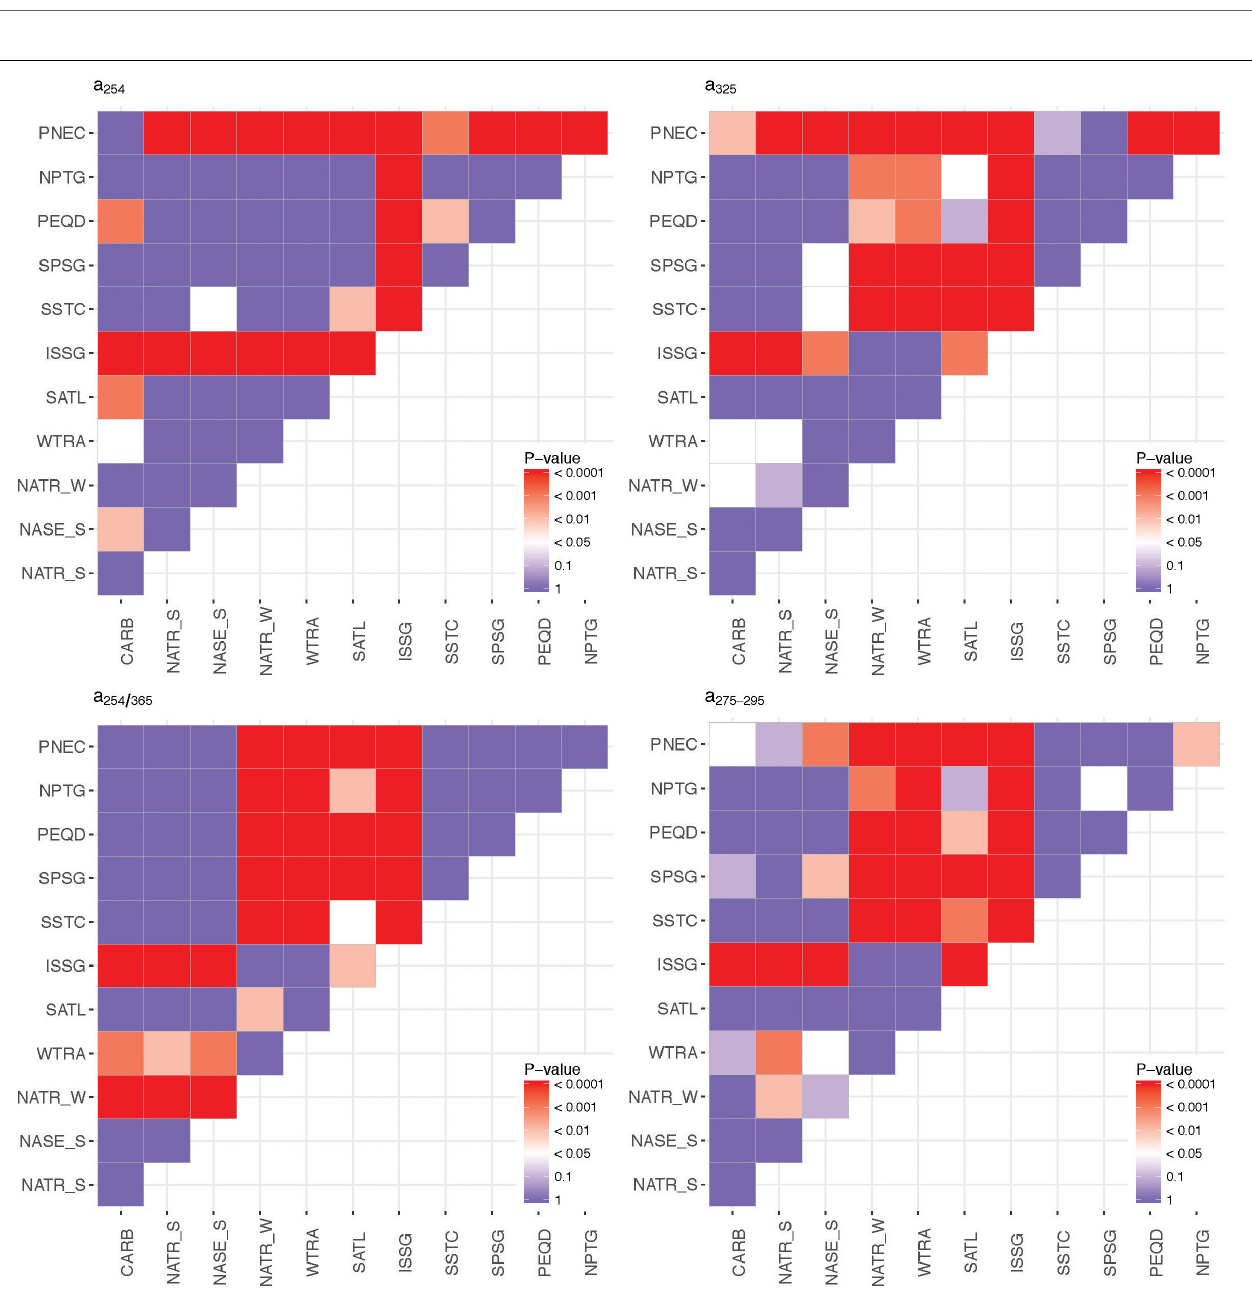
FIGURE 8 | P -value of the F-statistic resulted from the ANOVA applied to the four optical variables a 254 , a 325 , a 254 / 365 , S 275 − 295 to evaluate inter-province